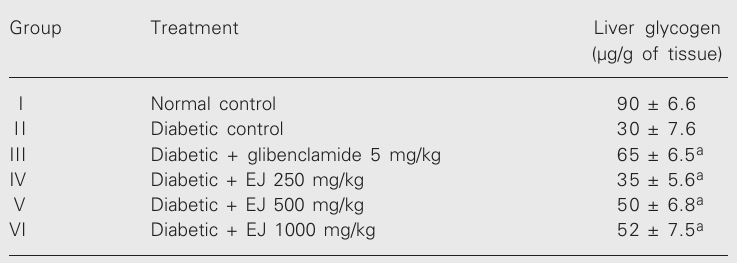
Table 3. Effect of Eugenia jambolana seed powder on liver glycogen of streptozoto- cin-diabetic